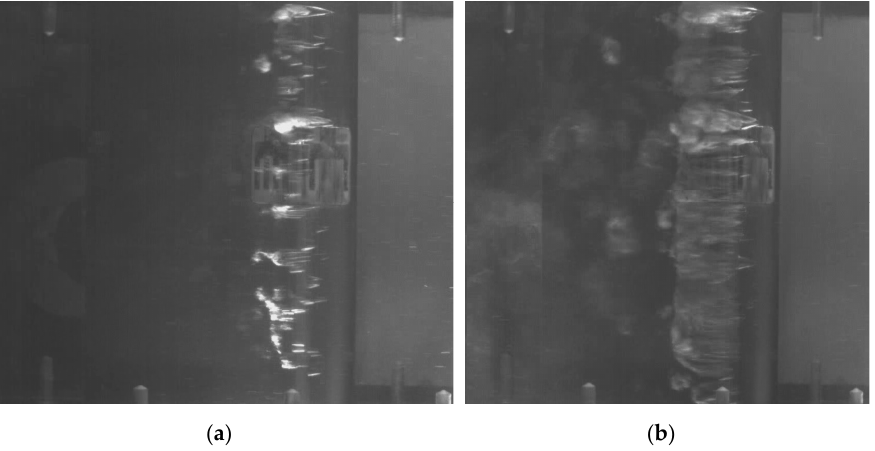
Figure 17. 3D Cavitation on upper side of hydrofoil. Experiment. ( a ) σ = 1.9; ( b ) σ = 1.83.